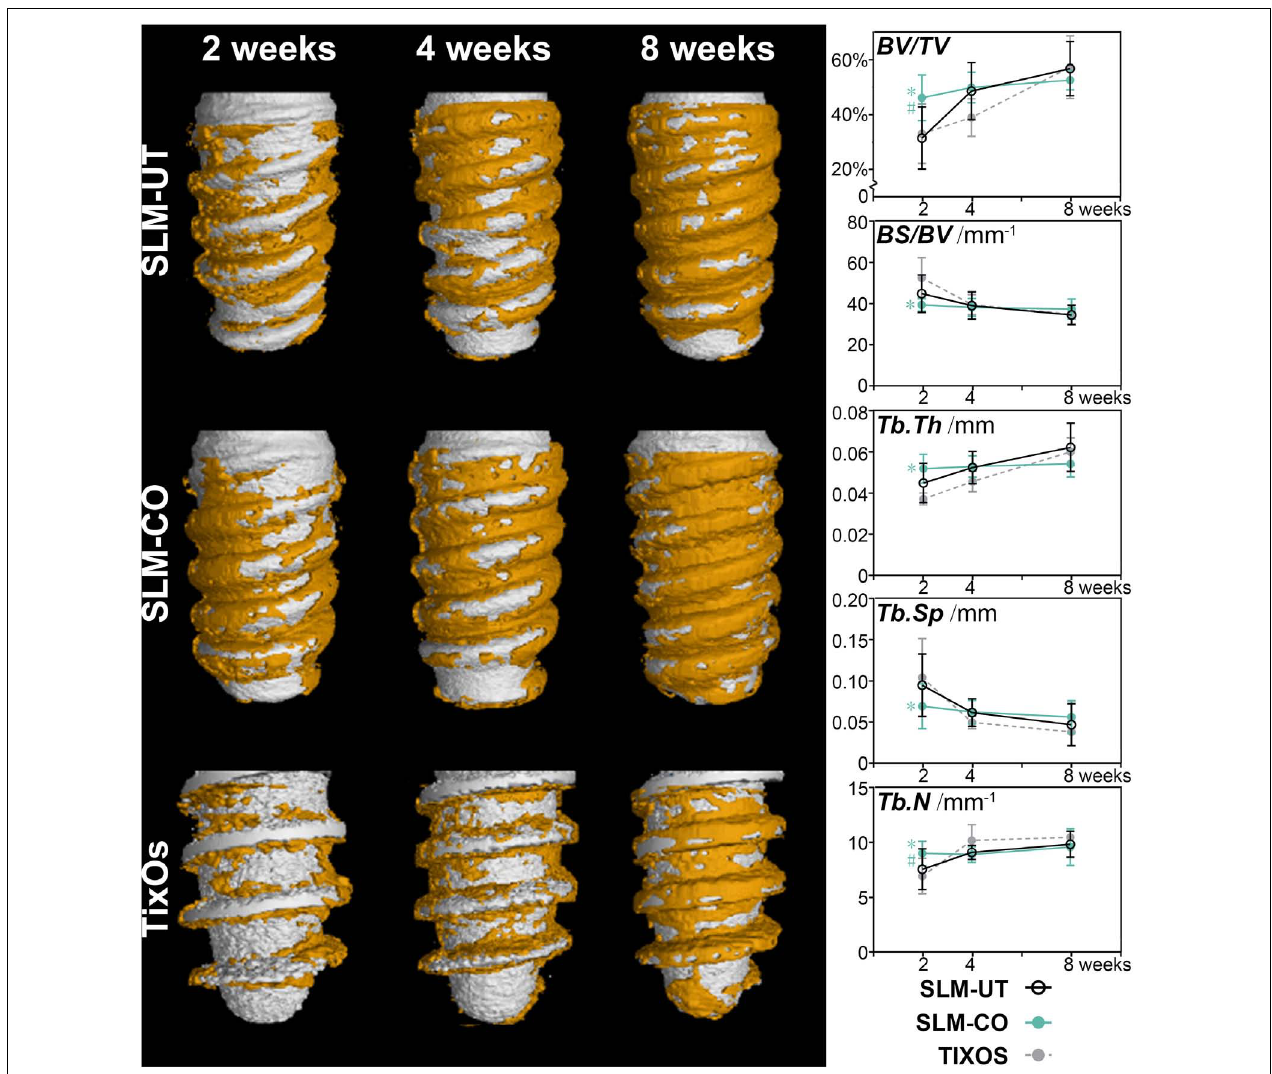
FIGURE 6 | The time sequence of osseointegration showed by micro-CT and the corresponding quantitative analysis of bone structural parameters (*significant difference between SLM-CO and TixOs, P < 0.05, # significant difference between SLM-CO and SLM-UT, P <